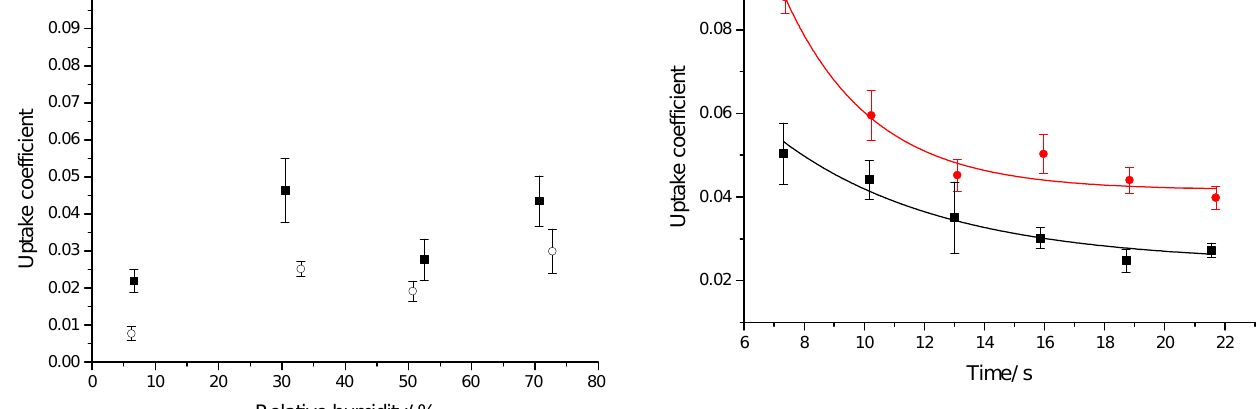
Figure 8. HO 2 uptake coefficients measured at a number of HO 2 -aerosol contact times (corresponding to different injector positions). Experiments were performed at 10% RH and at initial HO 2 concentrations of 1 × 10 9 molecule cm -3 (black squares) and 3 × 10 8 molecule cm -3 (red circles). The uptake coefficients correspond to the average value between t = 0 and the reaction time given. The error bars represent one standard deviation of the average of a number of repeated experiments. The solid lines are exponentially decaying functions γ = 0.58 exp (- t /2.9) + 0.042 and γ = 0.11 exp (- t /5.4) + 0.024 which are fitted to the data for 3 × 10 8 molecule cm -3 and 1 × 10 9 molecule cm -3 , respectively.